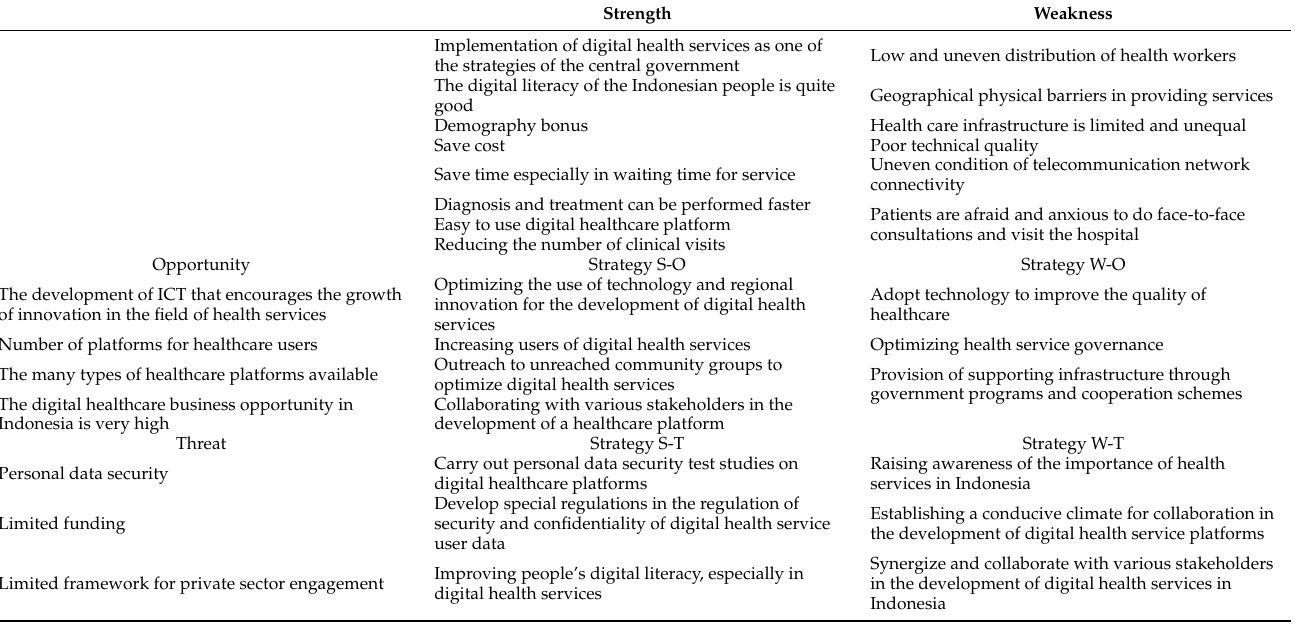
Table 3. SWOT Analysis of the Digital Transformation Implementation of Health Services in Indonesia.